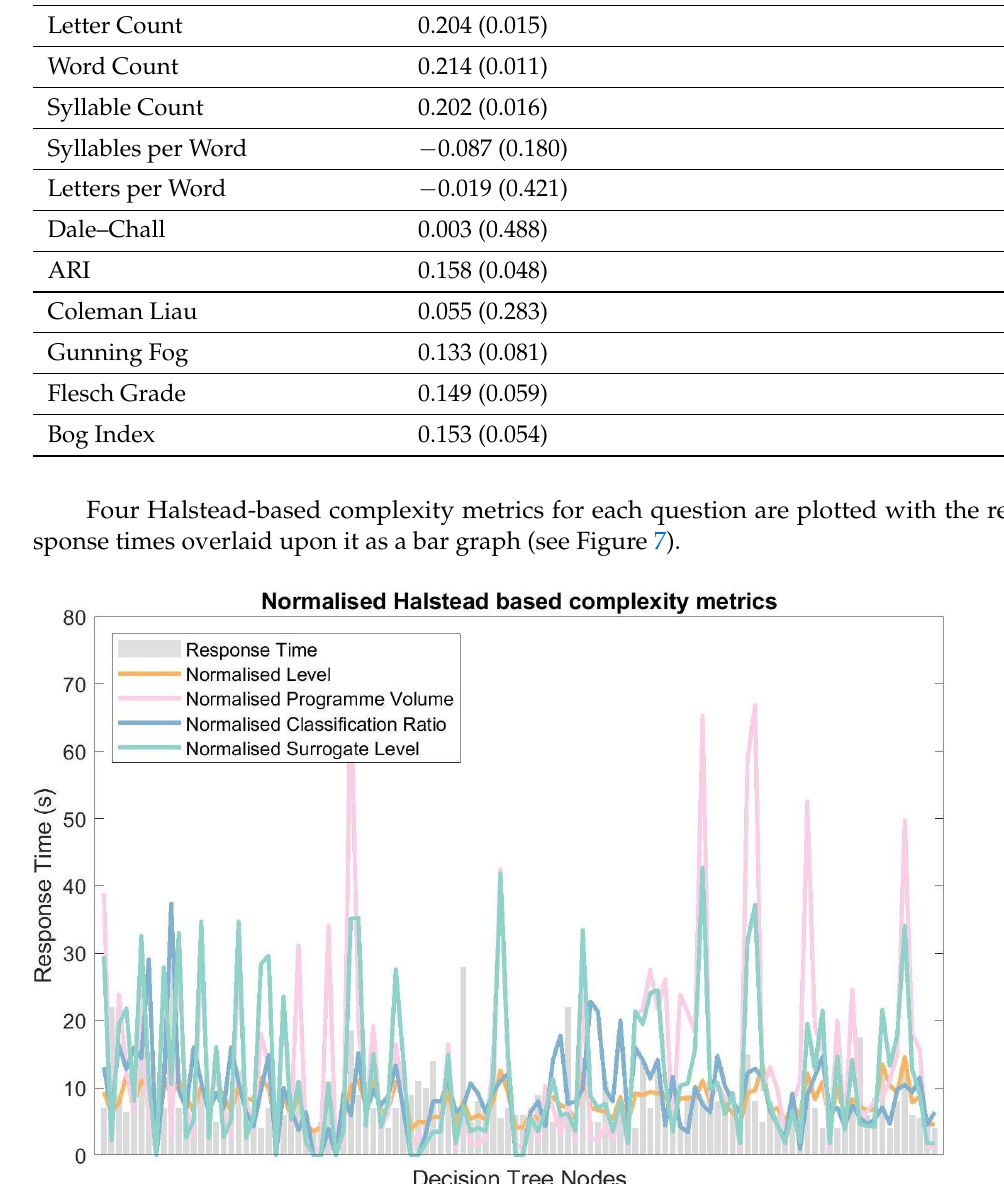
Figure 7. Normalised Halstead-based complexity metrics and response times (vertical axis) of individual nodes (horizontal